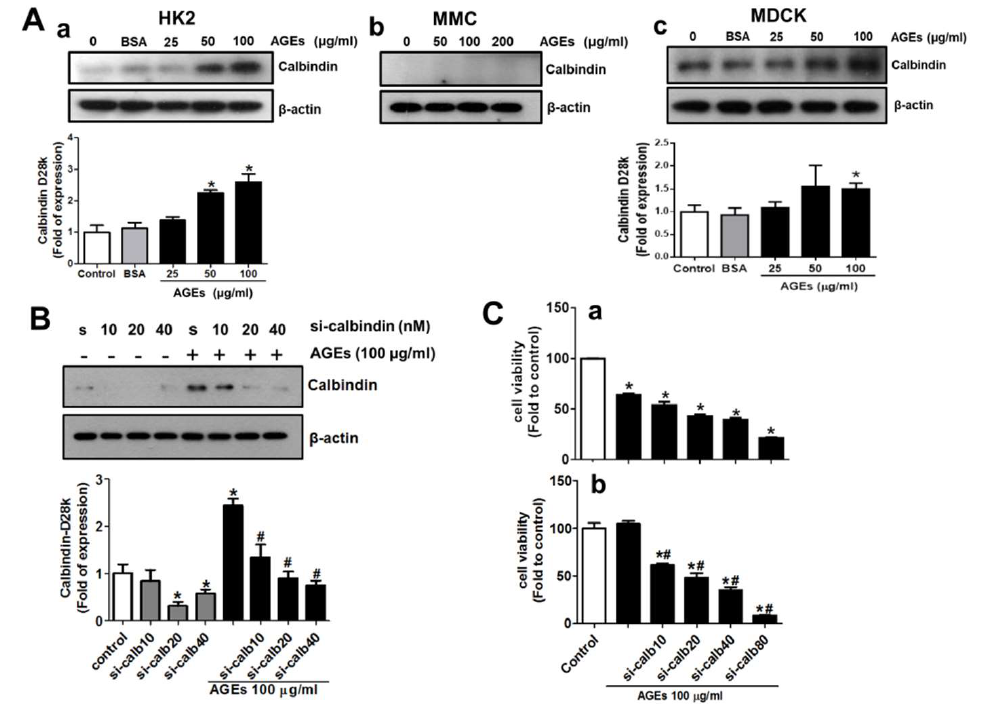
Figure 2. E ff ects of AGEs on protein expressions of calbindin-D28K in renal proximal tubule cells, mesangial cell, and distal tubule cells and calbindin-D28k silencing reduced cell viability in HK2 cells. ( A ) AGEs (25-200 µ g / mL) or BSA (100 µ g / mL) were added to renal proximal tubule cells (HK-2; a), mesangial cells (MMC; b), and distal tubule cells (MDCK; c) for 48 h. The protein expression was determined by Western blotting. Protein levels were quantified by densitometry and normalized by β -actin levels. Data are presented as means ± SEM (n = 5). * P < 0.05, vs. control group. ( B ) and ( C ) Cells were transfected with scramble (s or control; 40 or 80 nM) or calbindin-D28k siRNA (si-calbindin or si-calb5-80; 5–80 nM) for 6 h. Transfected cells were treated with or without AGEs (100 µ g / mL) for 48 h. Protein expression of calbindin-D28k was determined by Western blotting ( B ). Protein levels were quantified by densitometry and normalized by β -actin levels. Cell viability was determined by MTT assay ( C ). Data are presented as means ± SEM (n = 5). * P < 0.05, vs. scramble control group. # P < 0.05, vs. AGEs + scramble